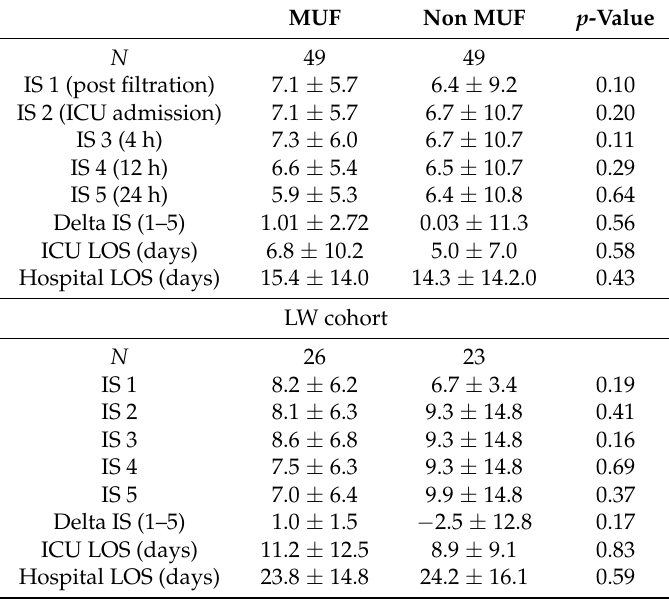
Table 7. Vasoactive inotrope scores, ICU, and hospital length of